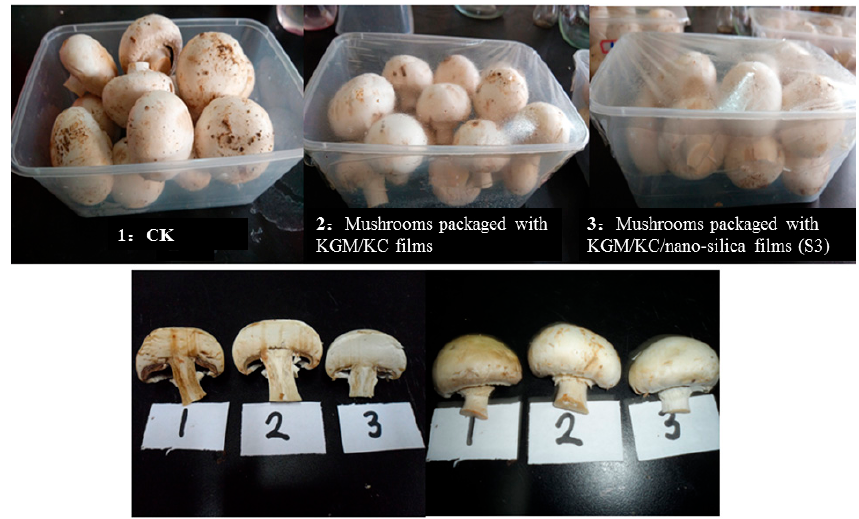
Figure 5. Effect of film packaging with Agaricus bisporus stored at 4 ± 1 ° C for 12 d (1: CK; 2: mushrooms packaged with KGM/KC films; 3: mushrooms packaged with KGM/KC/nano-silica films (S3)).